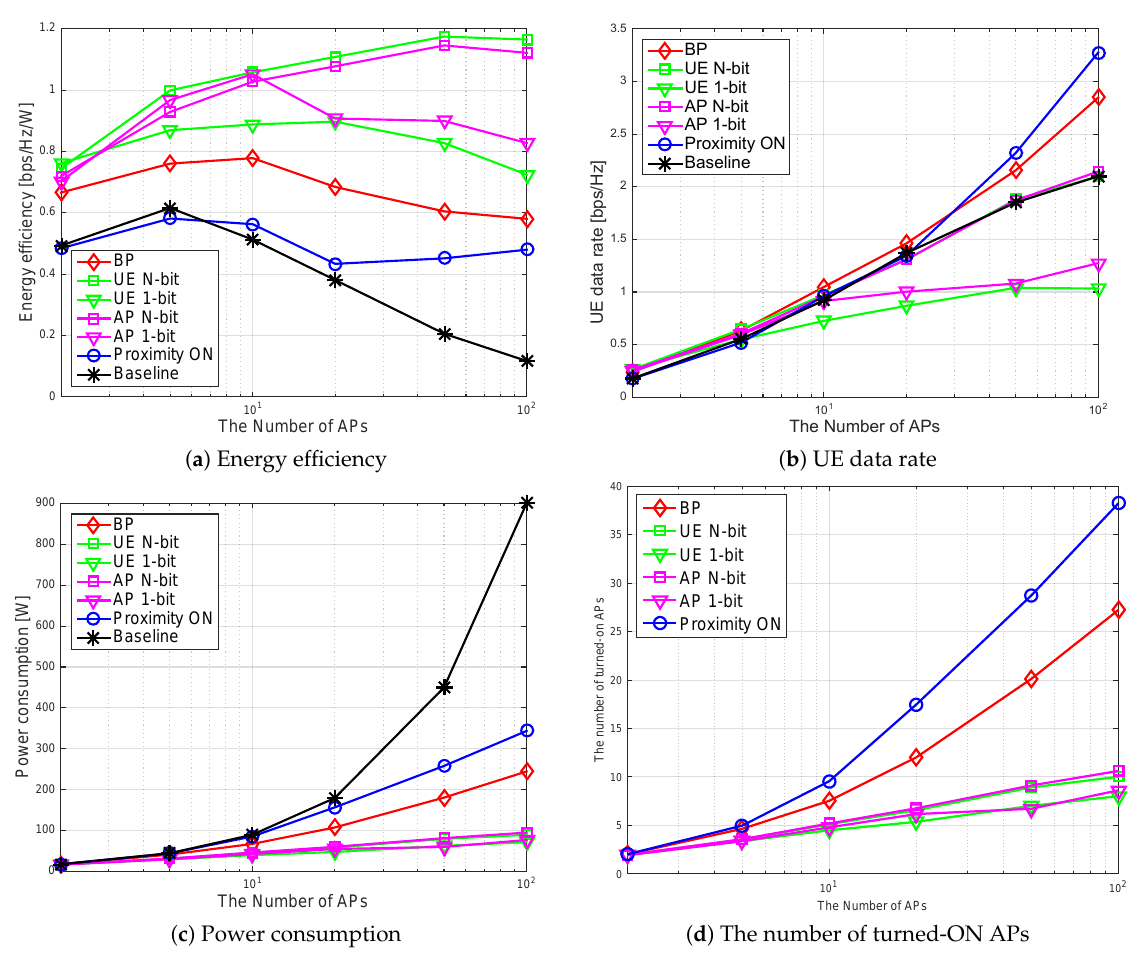
Figure 7. Green small cell operation under dense